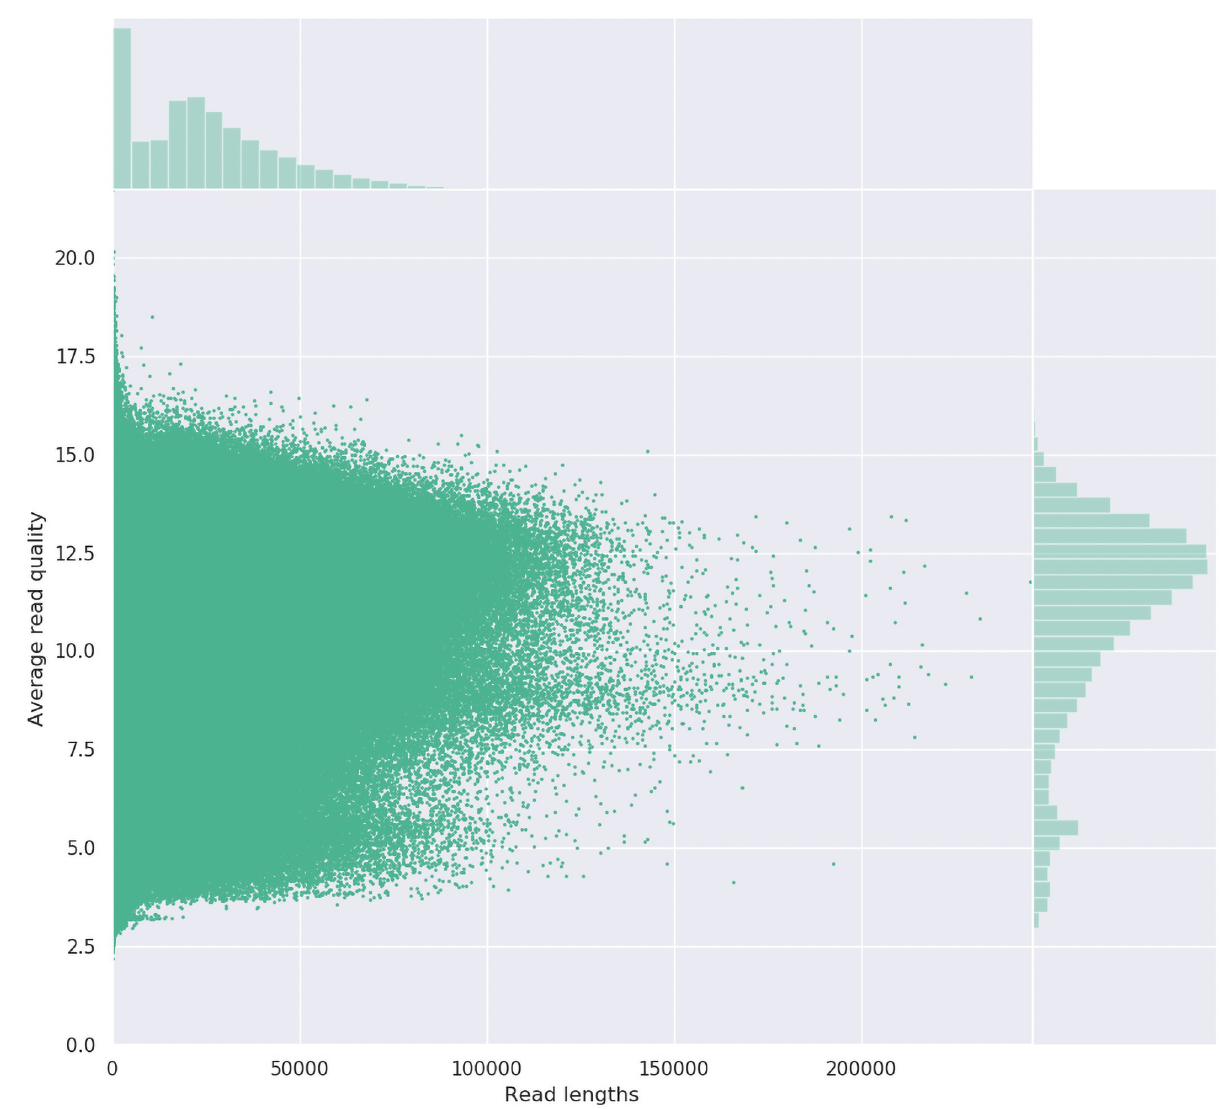
Fig 2. Read length by average read quality for Eucalyptus caleyi long-read sequencing with an Oxford Nanopore MinION flow cell. Image generated with NanoPlot 1.28.2 [10].